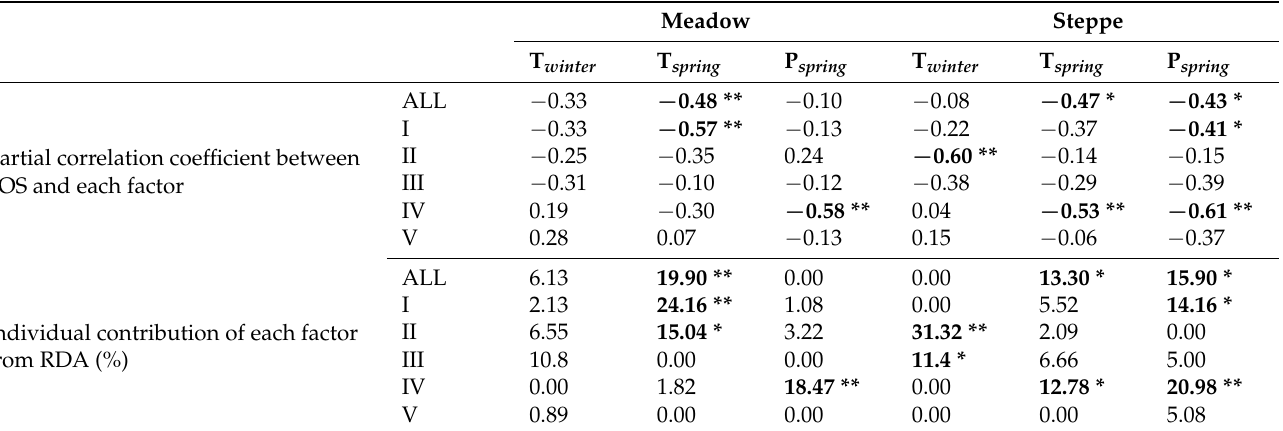
Table 2. Responses of SOS to T winter , T spring , and P spring for steppe and meadow in different ecoregions. Meadow Steppe T winter T spring P spring T winter T spring P